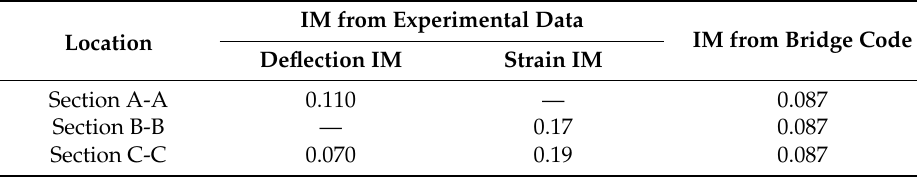
Table 1. Comparison between the IM from experimental data and the IM from bridge code.